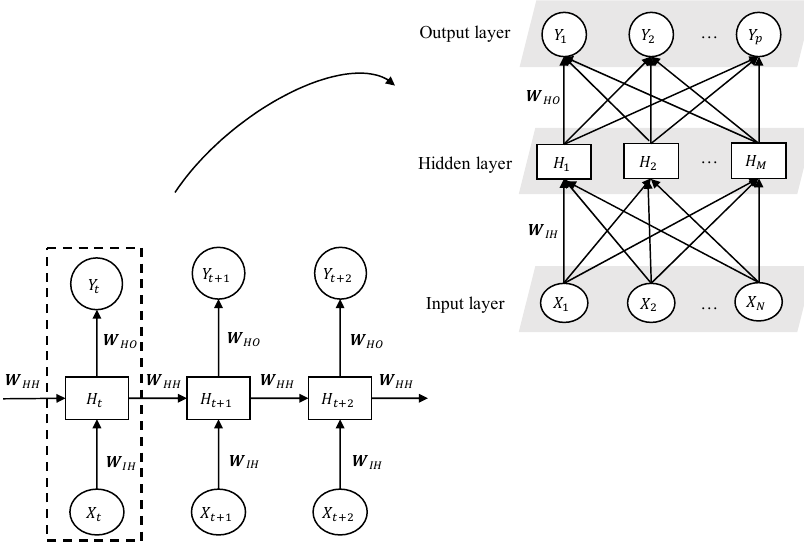
Figure 1. The structure of RNN.